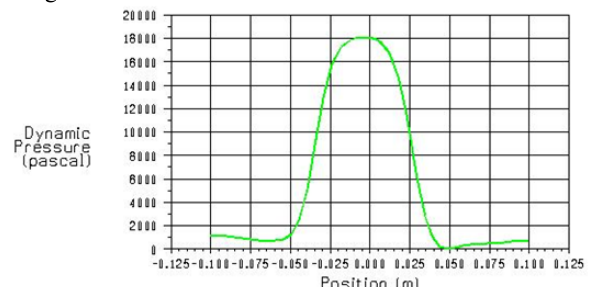
Fig. 3-13: Profile of the dynamic pressure in the vertical plane of the outlet section – a model of the straight outlet 4 Outlet changes